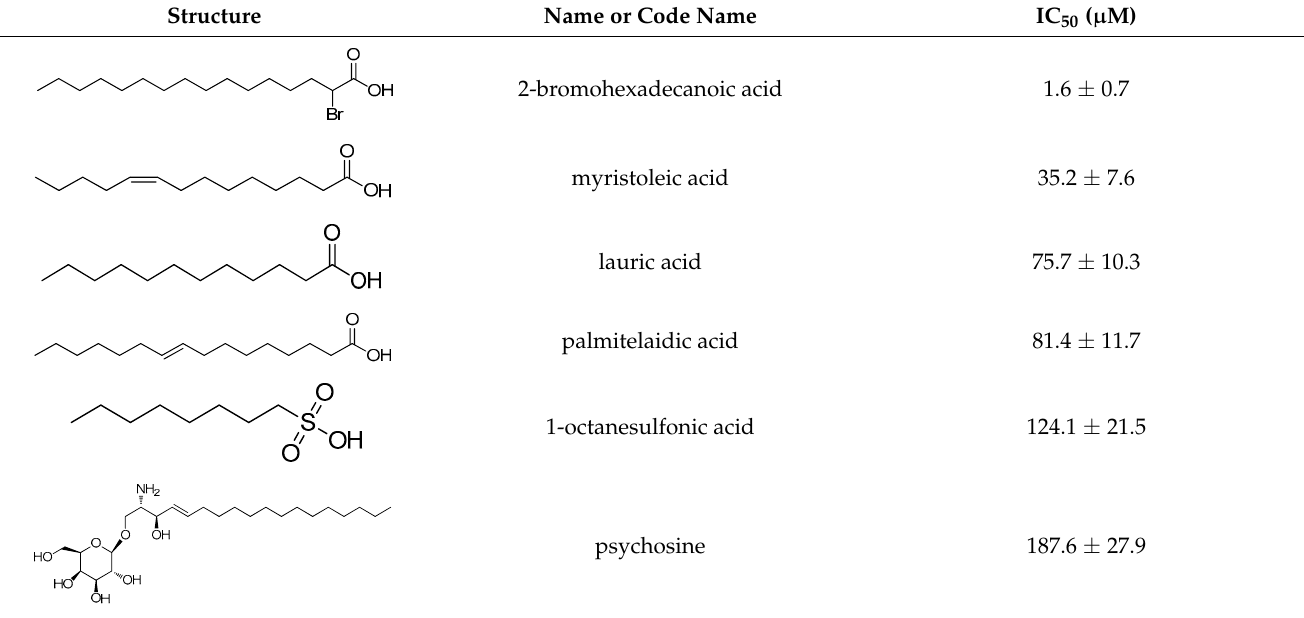
Table 1. The anthelmintic activity of (analogues of) pharbitin fragments (aglycon). Structure